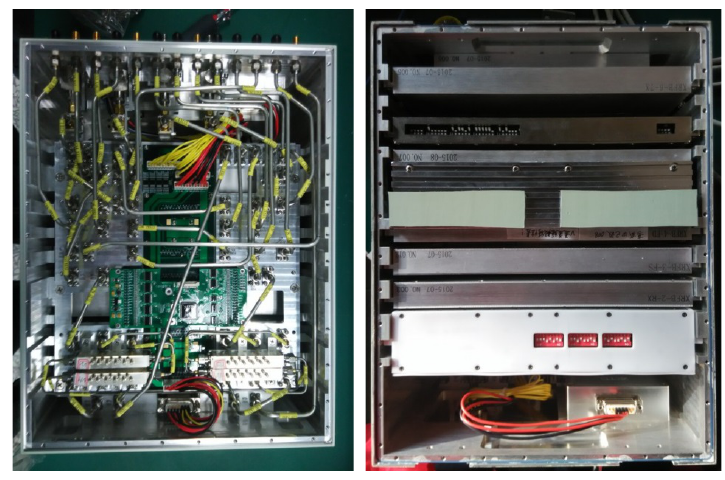
Figure 6. Outer view of the RF unit. Table 2. Characteristics of the four channels at 5400 MHz. PDBC: Phase difference between the four channels (based on the HH channel).